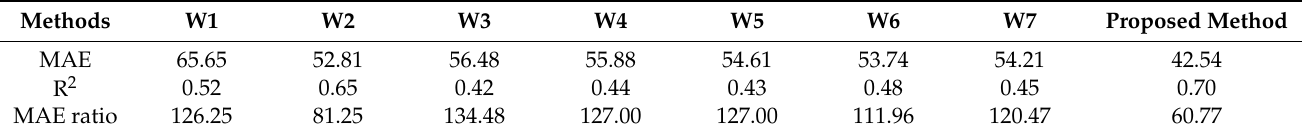
Table 7. Comparison Tilapia Weight Estimation of Proposed TWE-DRL method with seven area-based weight